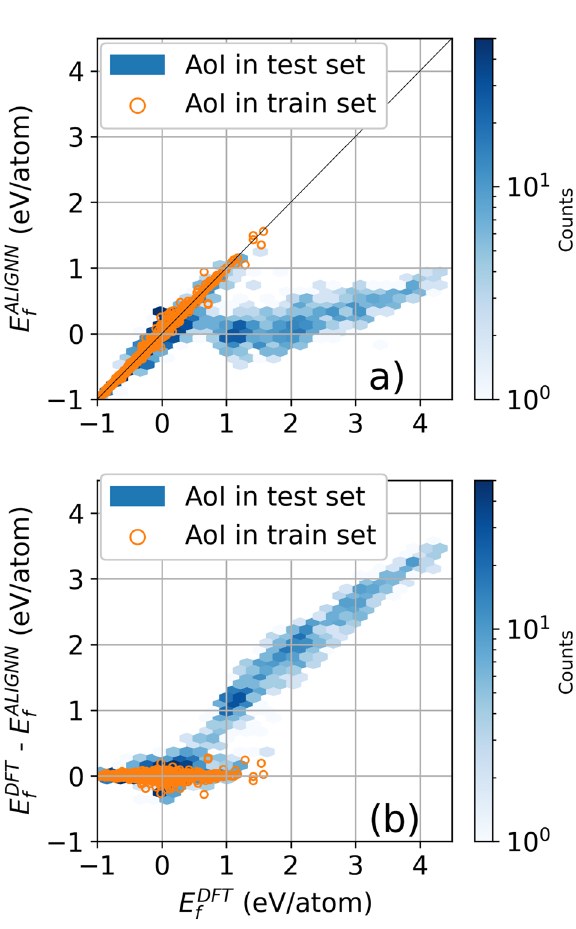
Fig. 1 Performance of the ALIGNN-MP18 model. a Parity plot and b prediction errors of the ALIGNN-MP18